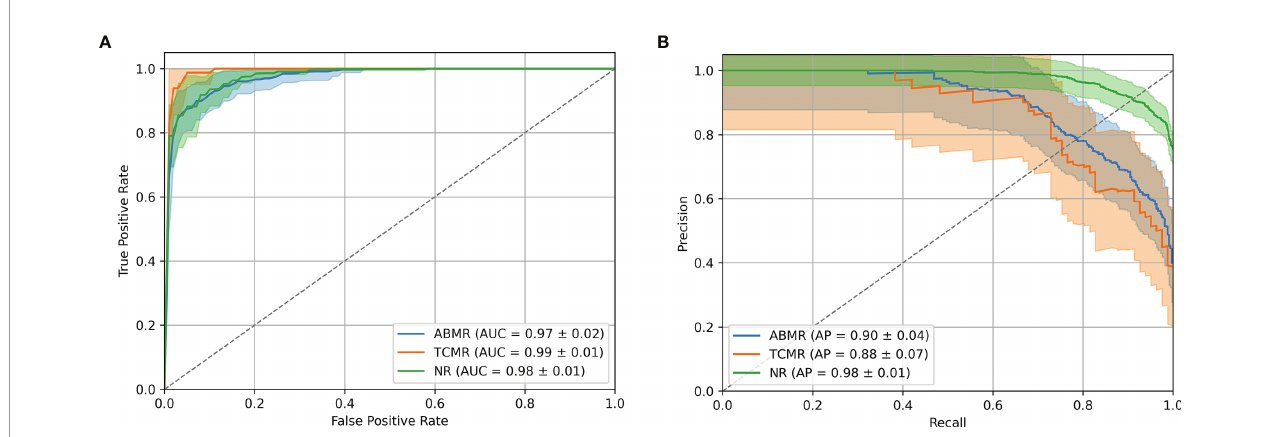
FIGURE 5 | B-HOT+ Model Performances. (A) ROC curve of cross-validation within GSE98320 of the B-HOT+ model. (B) Precision/Recall curve of cross-validation within GSE98320 of the B-HOT+ model. ABMR, Antibody-Mediated Rejection; AP, Average Precision; AUC, Area Under the ROC Curve; B-HOT, Banff-Human Organ Transplant; NR, Non-Rejection; ROC, Receiver Operating Characteristic; TCMR, T-Cell-Mediated Rejection.